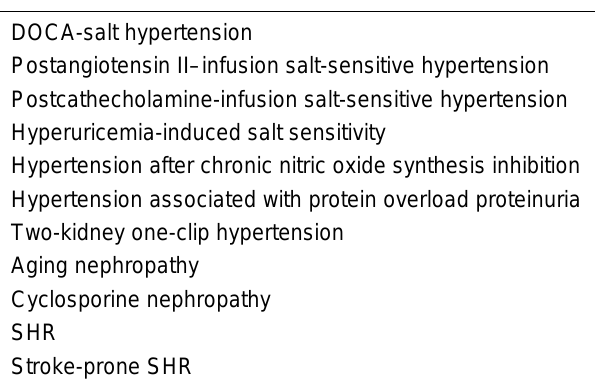
Models of Salt-Sensitive Hypertension Associated with Tubulointerstitial